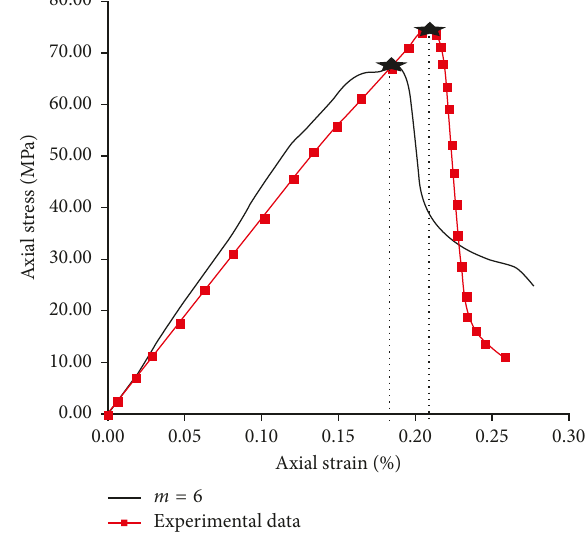
Figure 12: The overall stress-strain curve of the entire numerical sample and its comparison with the experimental